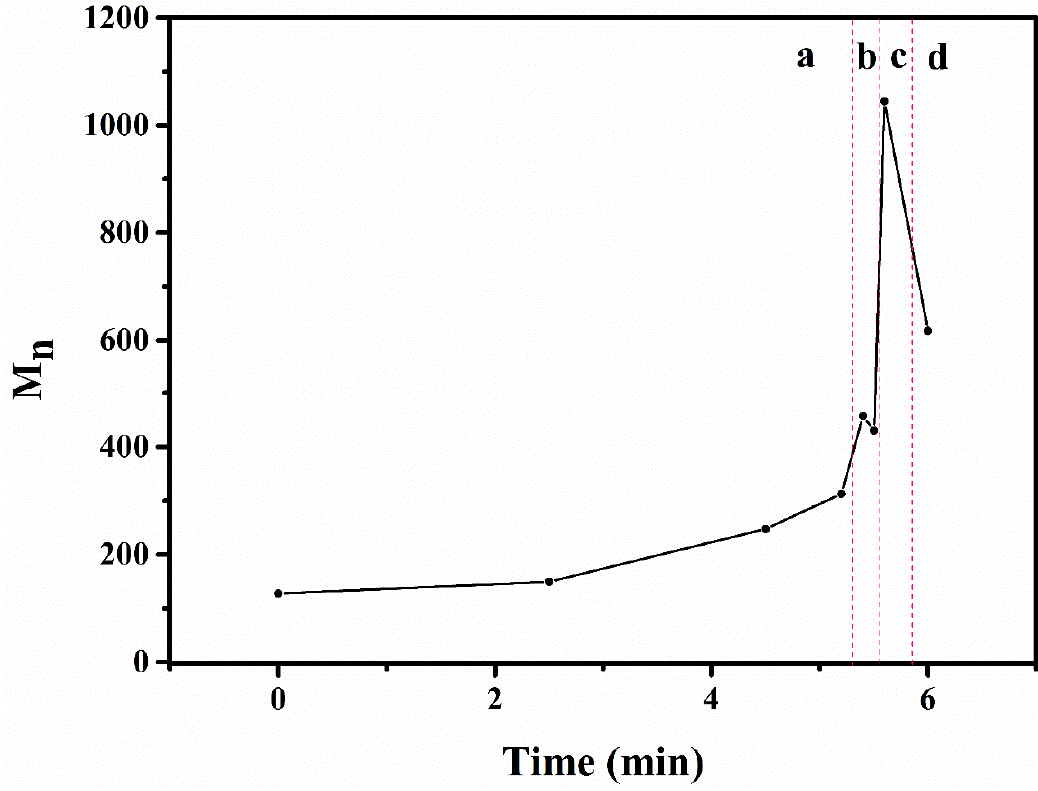
Figure 5. Number-average molecular weight of thermally treated sodium phenolate.